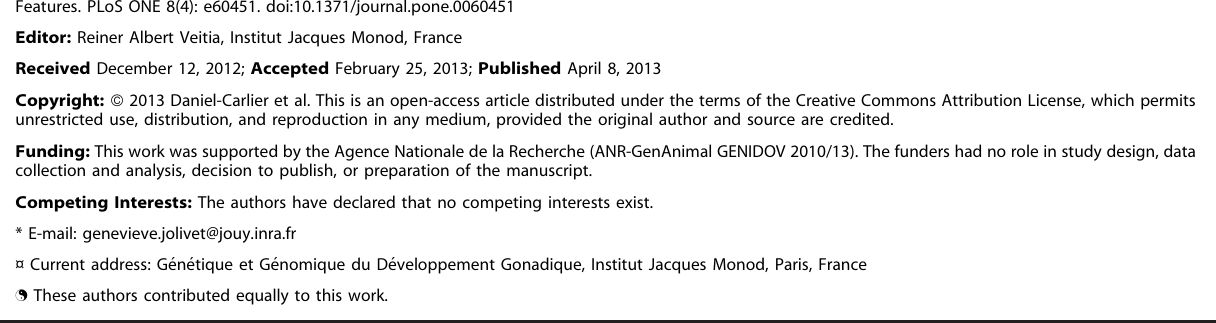
Figure 1. From a macroscopic point of view, rabbit